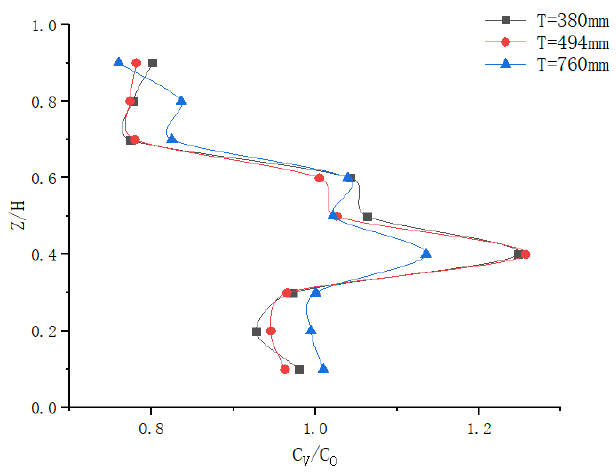
Figure 18. Verification of the optimized scale-up index at 5% v / v .